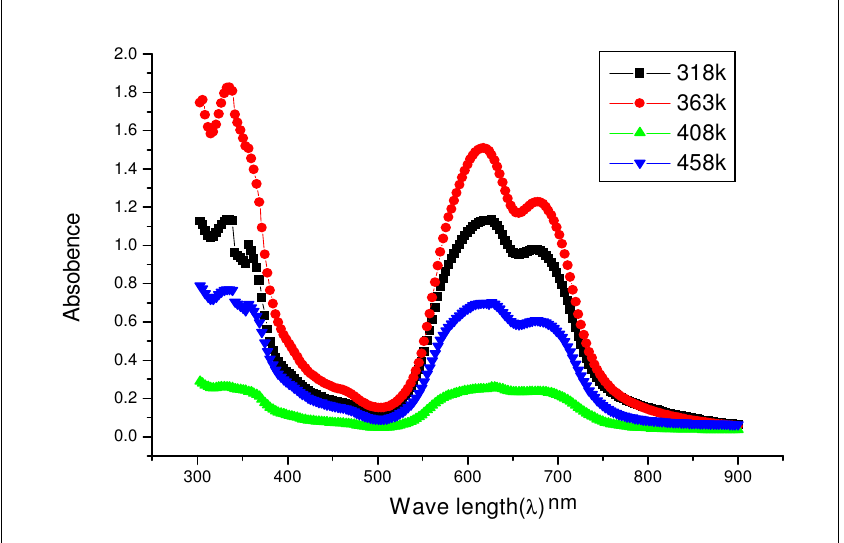
Figure 1. The absorption spectra for Nickel phthalocyanine thin films deposited at 318, 363, 408 and 458K temperatures.